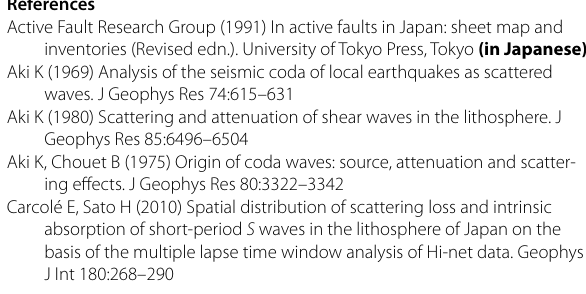
Additional file 1. Figure S1. The histogram of the time window length in each frequency band. Figure S2. The plot of the time window length versus the value of the coda Q in each frequency band. Figure S3. The spatial distribution of the standard deviation of the average value of the coda Q in each frequency